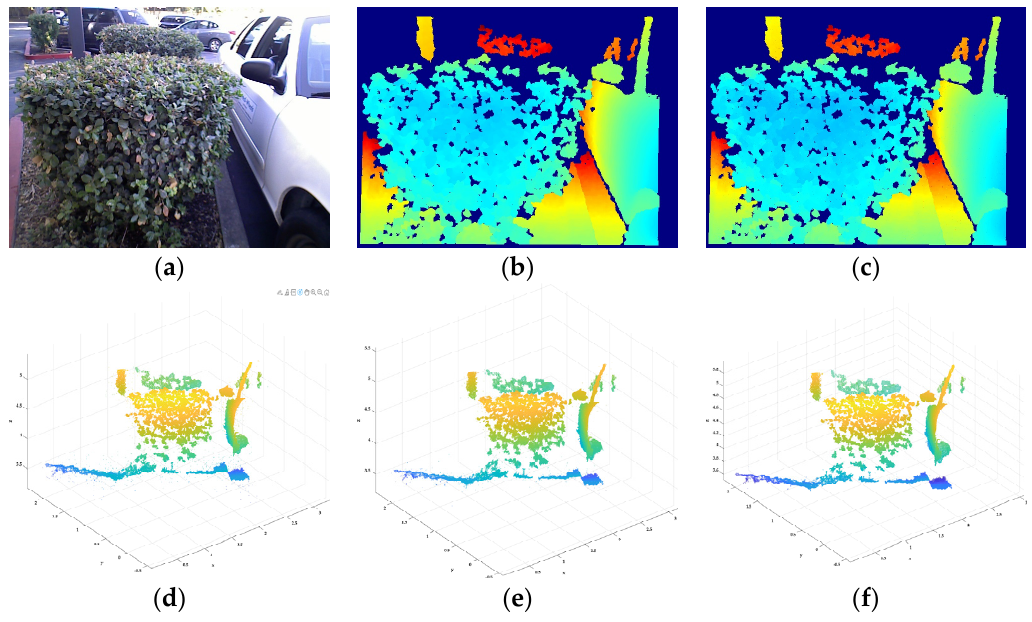
Figure 13. Denoising effects of fractional integral denoising and median filtering. ( a ) RGB image (dataset number 09860); ( b ) deep pseudo-colour map (dataset number 09860); ( c ) noise-free point cloud image; ( d ) point cloud image with added noise, PSNR = 43.457 dB; ( e ) point cloud image filtered by fractional integral denoising ( ν = − 0.4, PSNR = 51.289 dB); and ( f ) point cloud of the depth image after median filtering and denoising (PSNR = 37.326 dB).